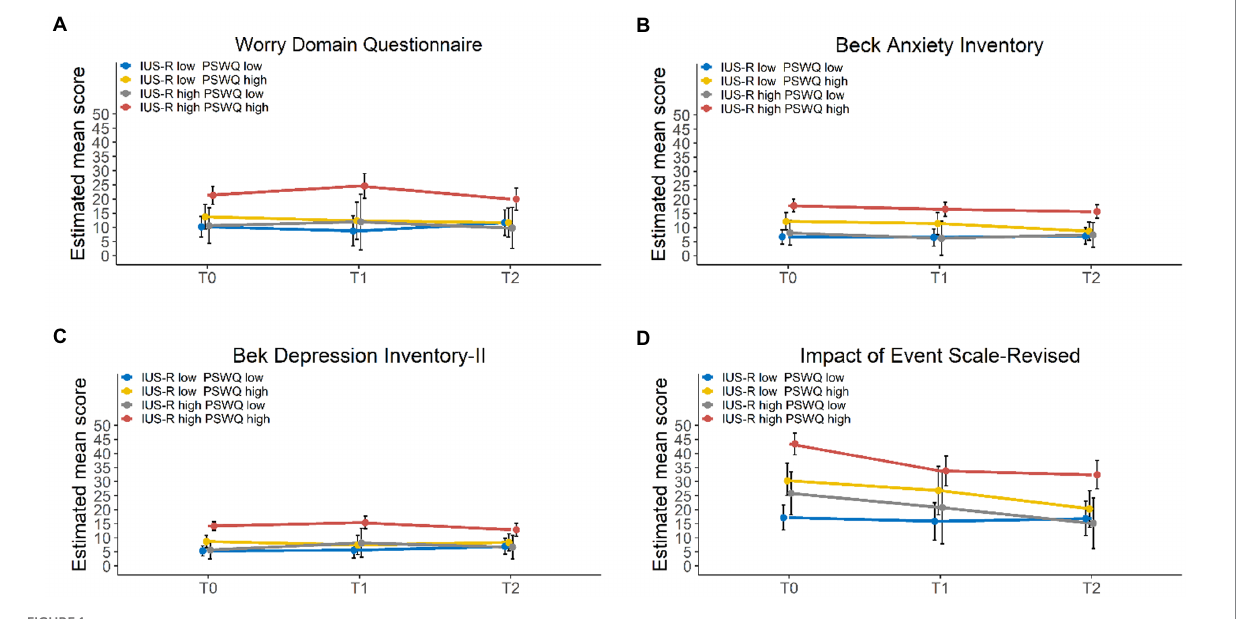
FIGURE 1 Trends over time of the WDQ (A) , BAI (B) , BDI-II (C) , and IES-R (D) scores of 4 groups divided based on the PSWQ and the IUS-R clinical cut-off (T0: N = 150; T1: N = 85; T2: N = 96). PSWQ = Penn State Worry Questionnaire; IUS-R = Intolerance of Uncertainty-Revised. T0: at diagnosis, T1: 3 months post- diagnosis, T2: 12 months